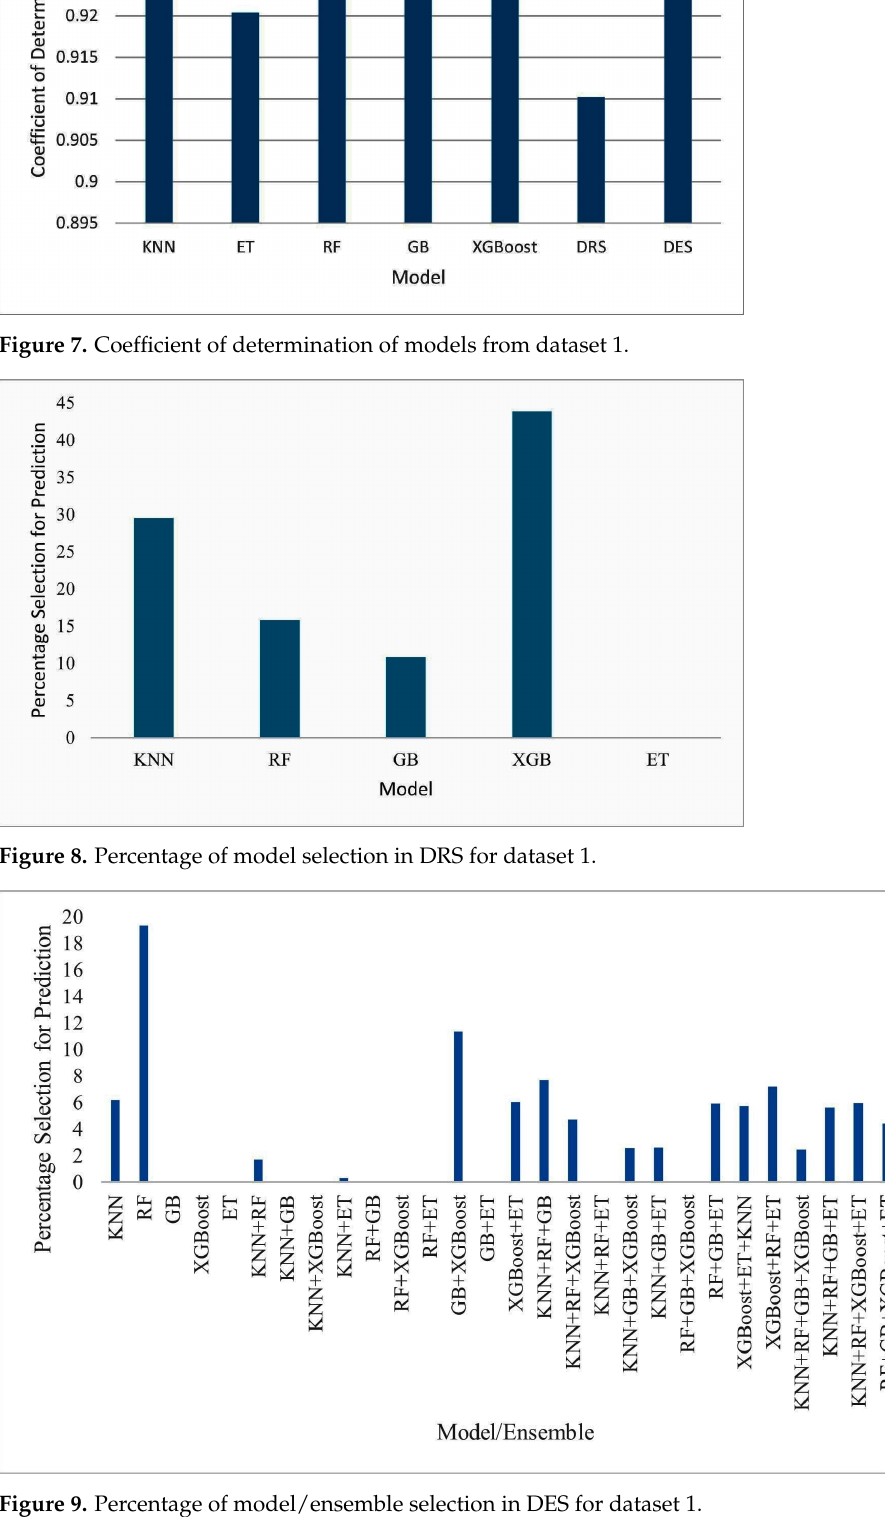
Figure 9. Percentage of model/ensemble selection in DES for dataset